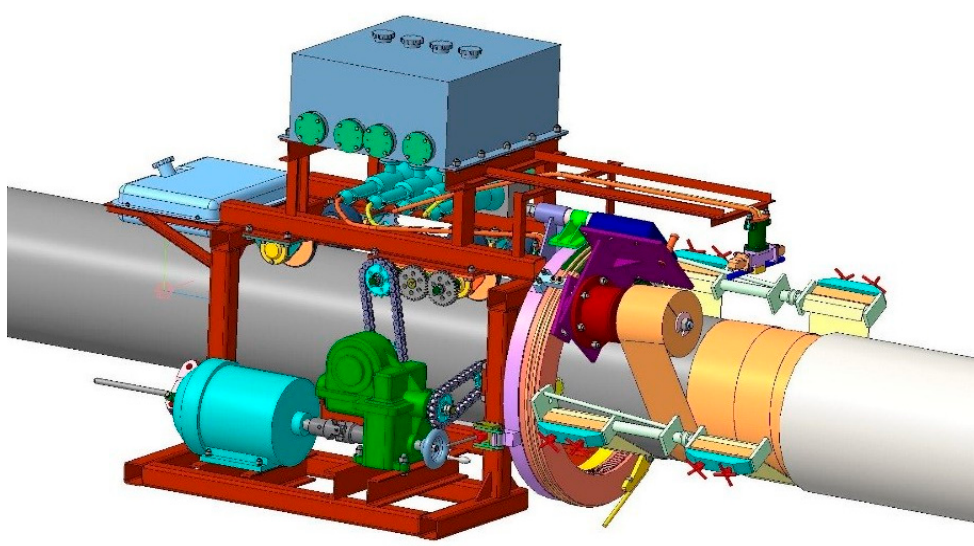
Figure 1. Winding insulating coating on a